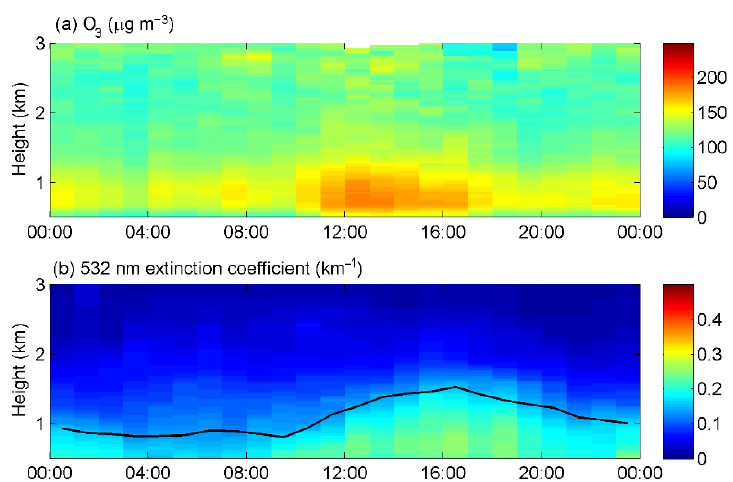
Figure 7. Diurnal variations in vertical structures of ( a ) ozone concentration and ( b ) aerosol extinction coefficient during the Lidar observation period in spring. The black line indicates the PBLH.